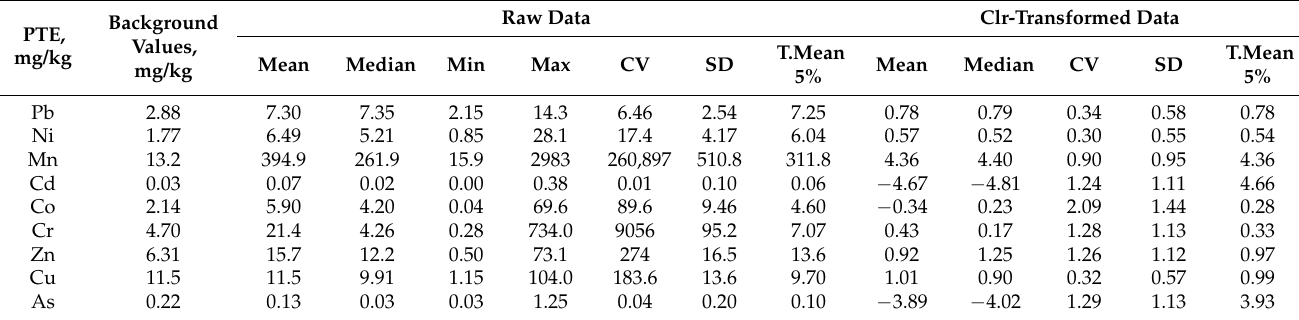
Table 2. Descriptive statistics for